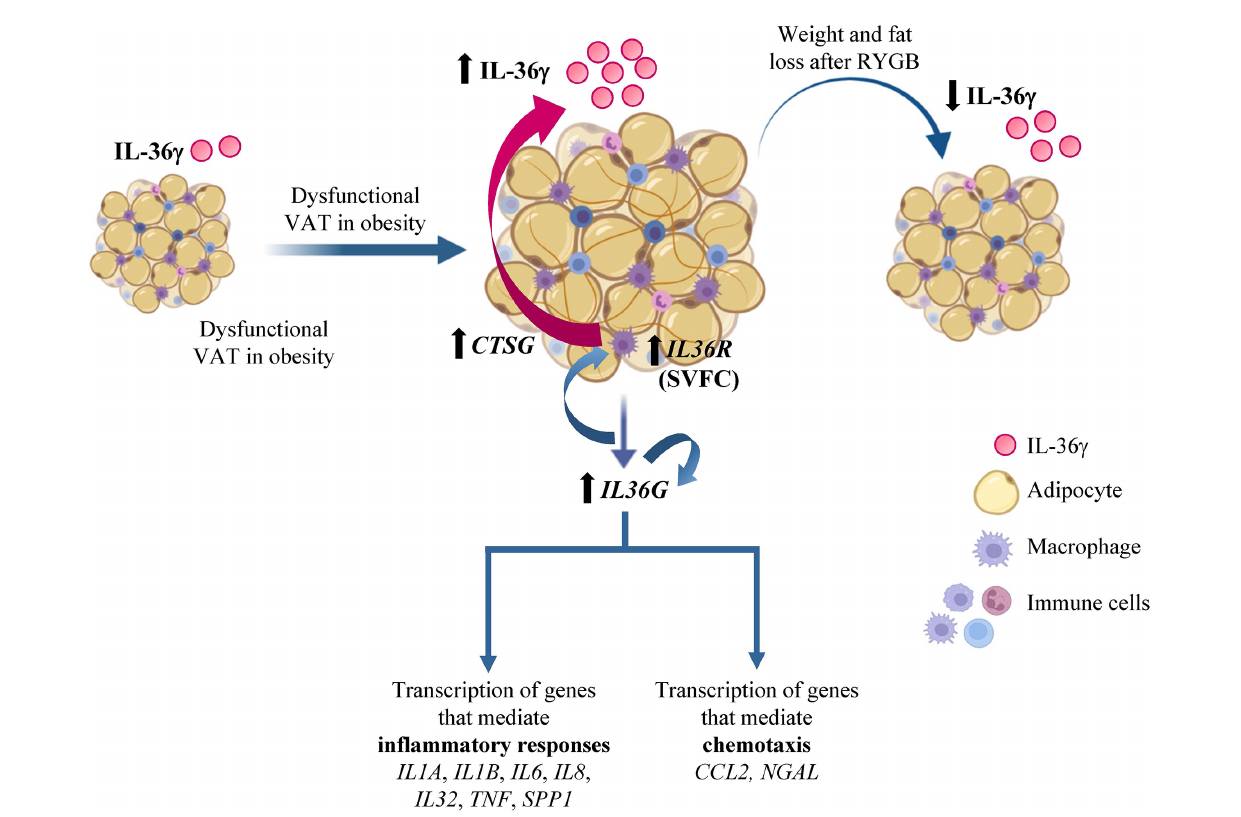
FIGURE 7 | IL-36 g in obesity and adipose tissue in fl ammation. Increased circulating concentrations of interleukin (IL)-36 g in patients with obesity and type 2 diabetes decreased after weight loss achieved by Roux-en-Y gastric bypass. Moreover, gene expression levels of IL36G and its receptor ( IL36R ) in dysfunctional visceral adipose tissue (VAT) associated to obesity are increased, mainly due to the stromovascular fraction cells (SVFC). The elevated synthesis of IL-36 g promotes its own expression as well as crucial molecules involved in in fl ammatory pathways and chemotaxis signaling. Moreover, IL-36 g also induce the expression of CTSG and the release of IL-36 g from macrophages. CCL2 , monocyte chemoattractant protein-1; COL , collagen; CTSG , cathepsin G; IL , interleukin; NGAL , lipocalin 2; RYGB, Roux-en-Y gastric bypass; SPP1 , osteopontin; TNF , tumor necrosis factor- a